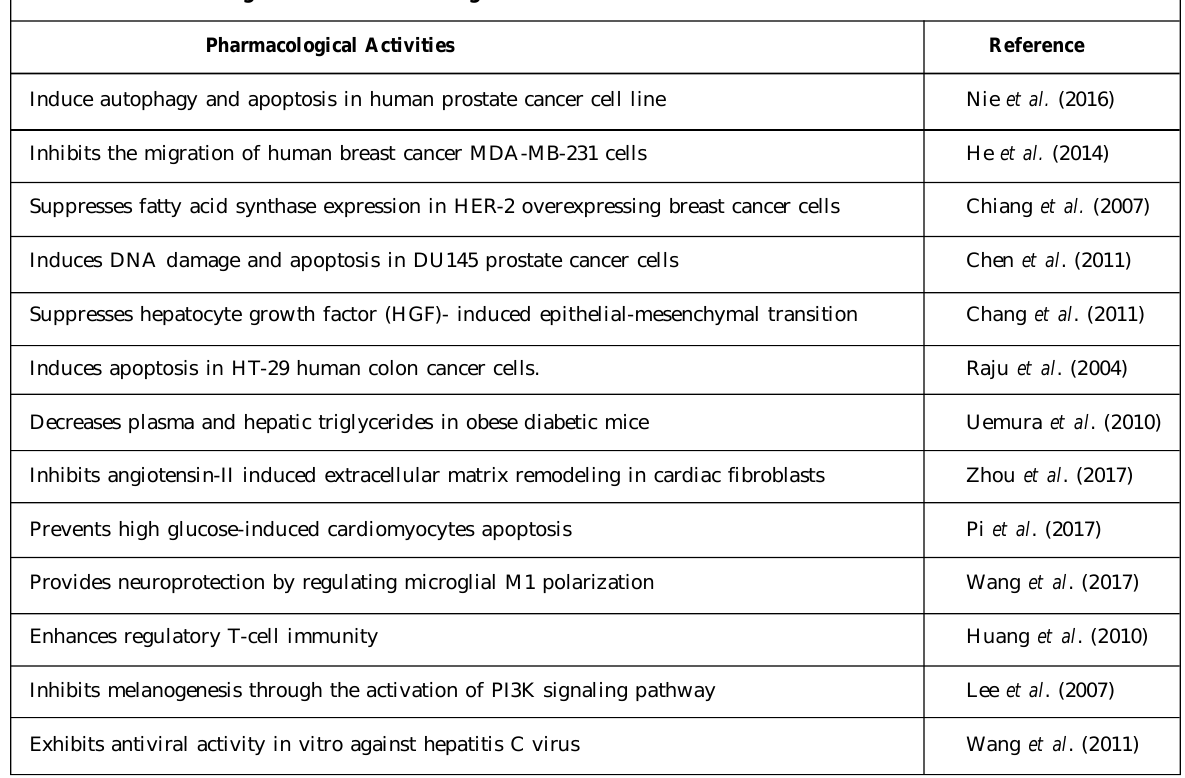
Table 2: Pharmacological activities of diosgenin Pharmacological